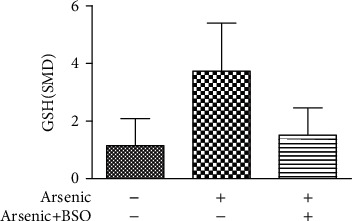
Effect of in vitro arsenic combined with r-GCS inhibitor on GSH. SMD: standardized mean difference. Compared with control, the P value of the arsenic group's overall effect test was <0.001, and the P value of the arsenic+BSO group's overall effect test was <0.001. When P < 0.05, the difference was considered statistically significant.